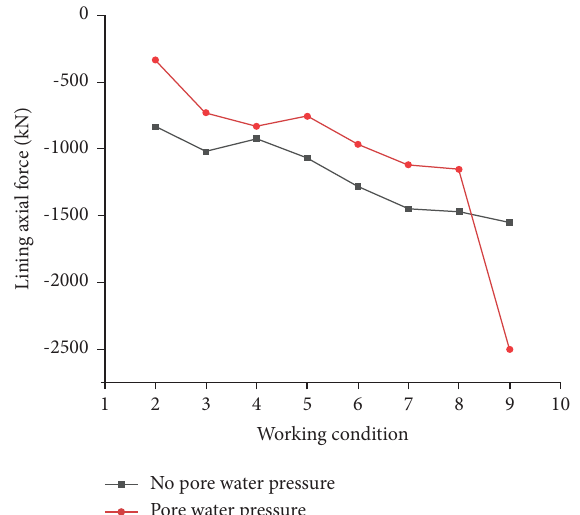
Figure 37: Maximum liner axial force on the foundation pit lining across conditions.